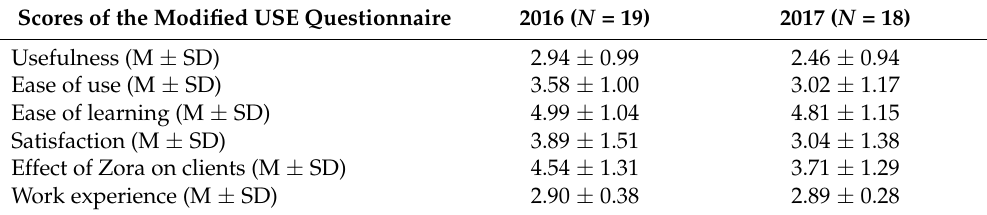
Table 3. The scores of the modified Usefulness, Satisfaction, Ease of Use (USE) questionnaire, scored on a seven point Likert scale (except work experience five point scale). Given is the Mean (M) and Standard Deviation